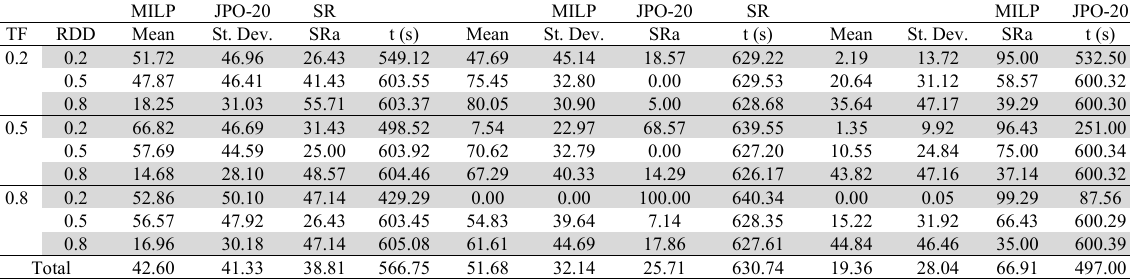
RDI and Success rate values for TF and